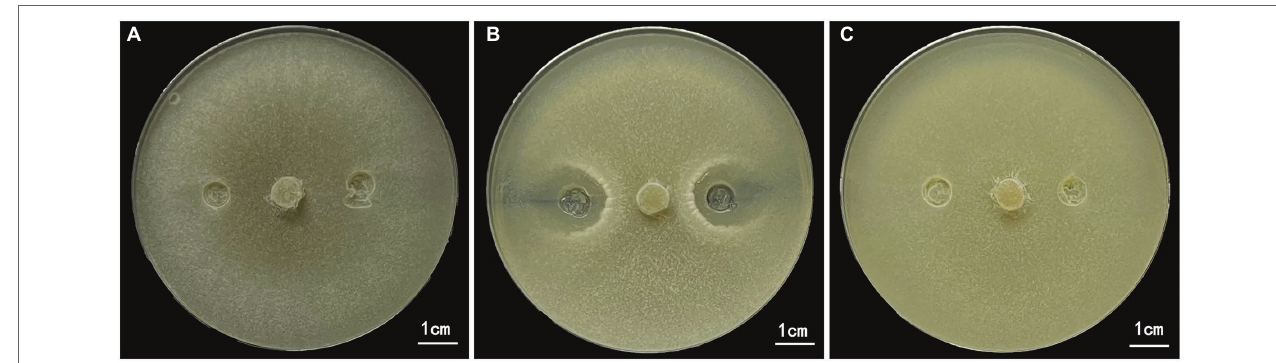
FIGURE 3 | Inhibition effect of extracellular and intracellular products of Bacillus amyloliquefaciens on the growth of S. sclerotida. (A) Control, sterile normal saline treatment. (B) B. amyloliquefaciens extracellular products treatment. (C) B. amyloliquefaciens intracellular products treatment. Sterile normal saline, extracellular and intracellular products were inoculated at 1/4 and 3/4 of the diameter of the Petri